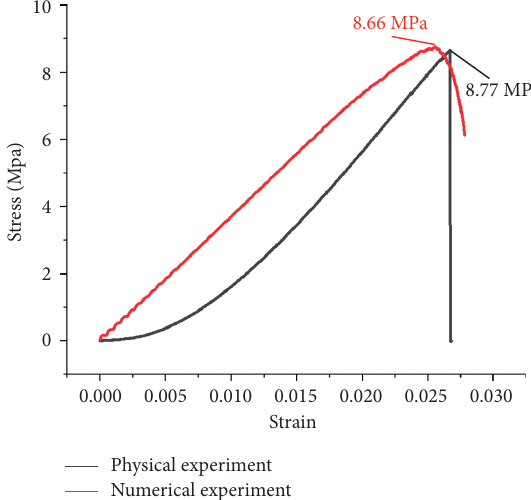
Figure 9: Comparison of numerical simulation and experimental stress-strain curves for coal samples under uniaxial